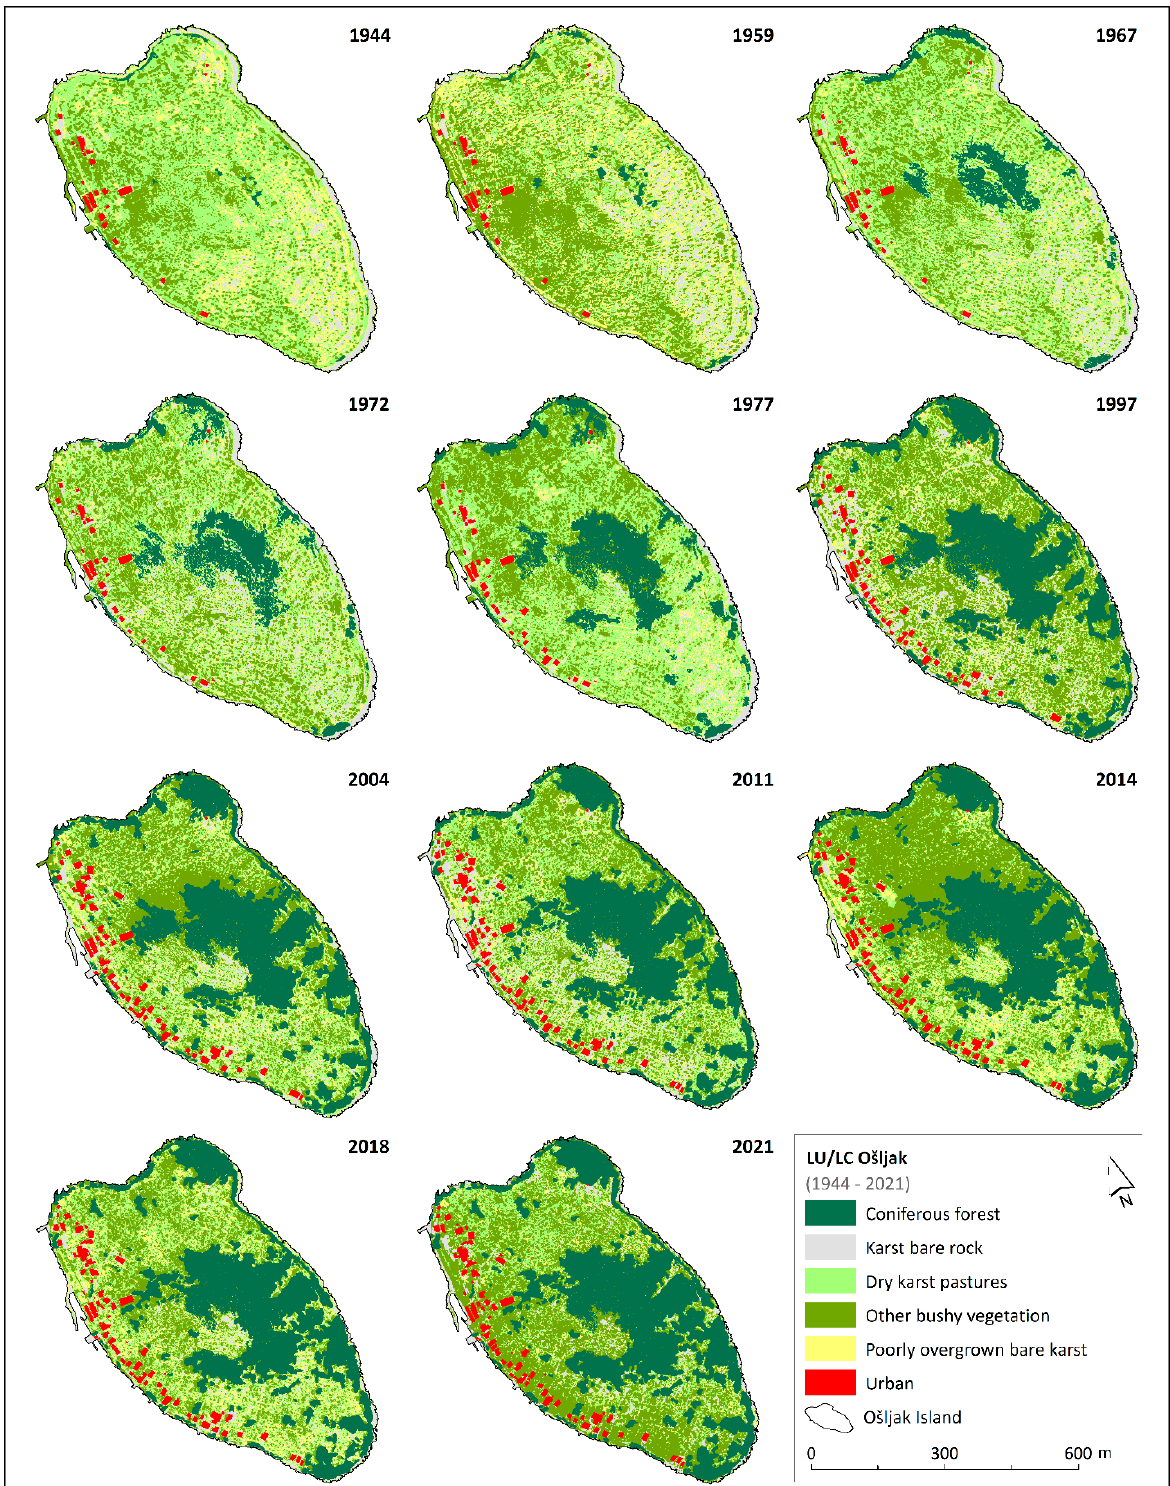
Figure 14 . LU/LC models for Ošljak Island in the time period (1944–2021) . Figure 14. LU/LC models for Ošljak Island in the time period